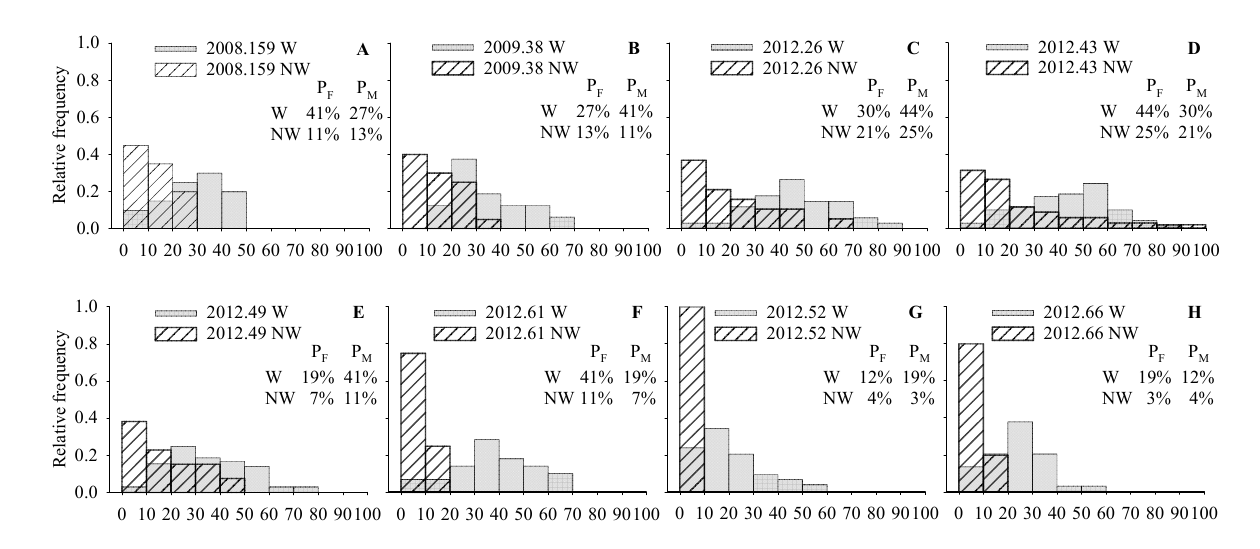
Under the W treatment the seedlings the LA followed approximately normal distri- bution. On the other hand, NW treatment exhibited seedling distribution like Lognormal or Weibull, concentrated in classes of lower LA (0–10 and 10–20% of the area affected by lesion) (Figure 2).